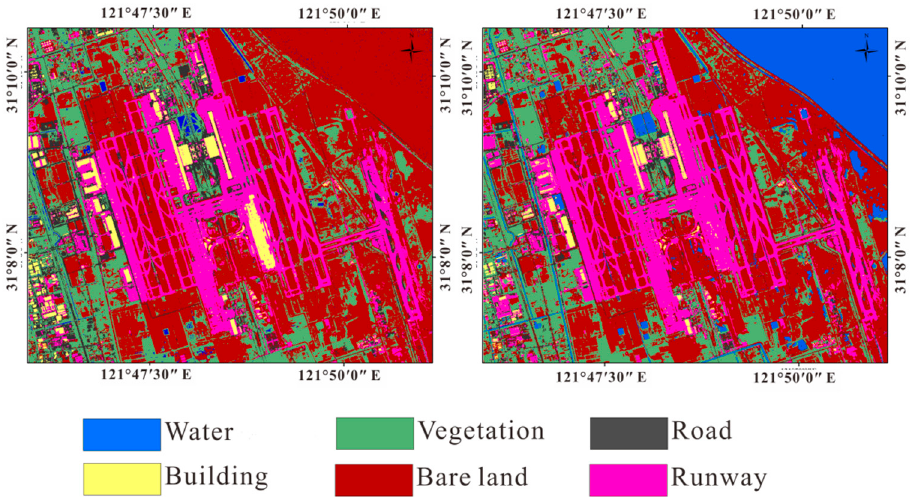
Figure 9. The left image is the classification result of the true color image. The right image is the classification result of the standard false color images.